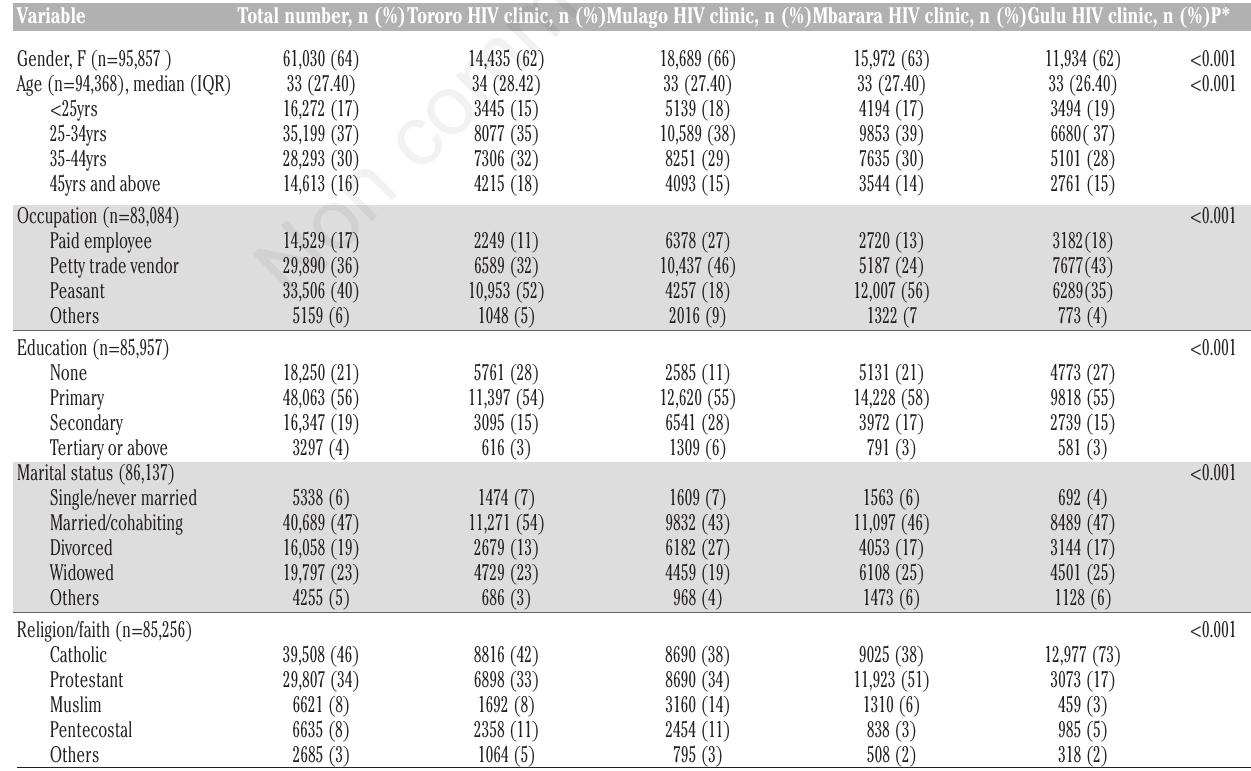
Table 1. Demographic characteristics of the study participants, total and clinic-specific.